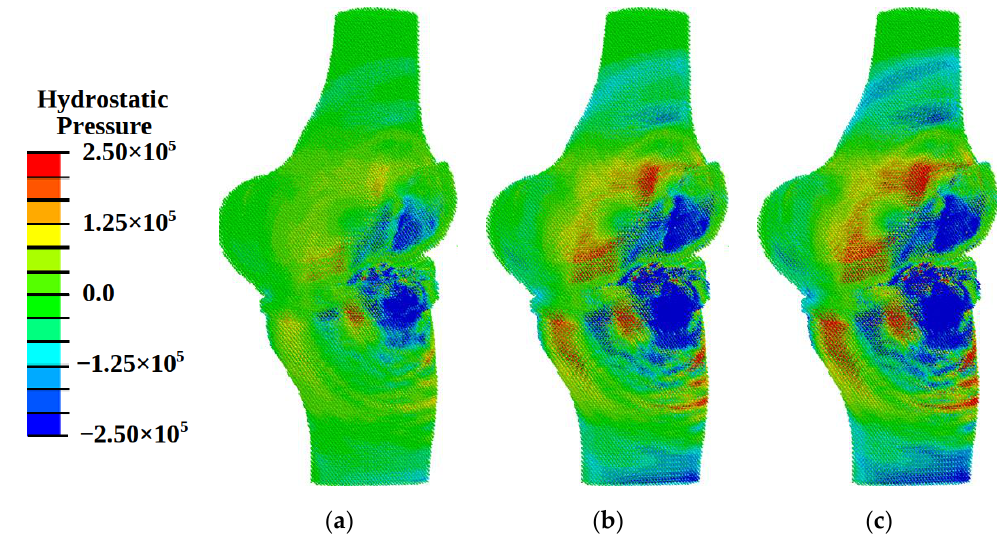
Figure 7. Fields of hydrostatic pressure (Pa) at different energy flux density of shock wave: ( a ) 0.12 mJ/mm 2 ; ( b ) 0.33 mJ/mm 2 ; ( c ) 0.8 mJ/mm 2 .